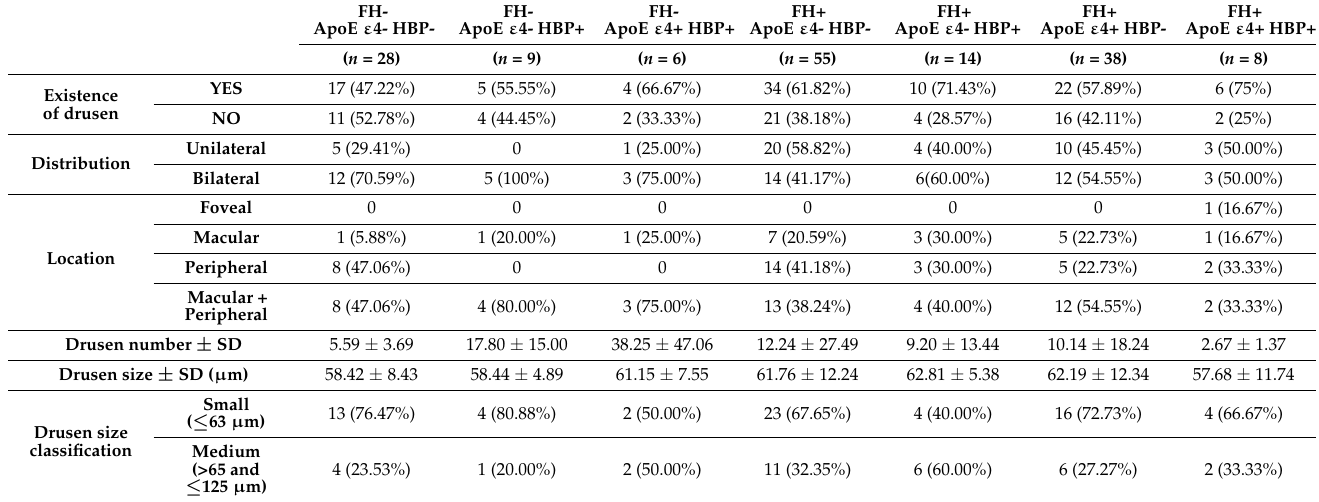
cation between groups. The groups with a greater number of subjects with drusen were FH+ ApoE ε 4+ HBP+ (75%), and FH+ ApoE ε 4- HBP+ (71.43%) and the group with less